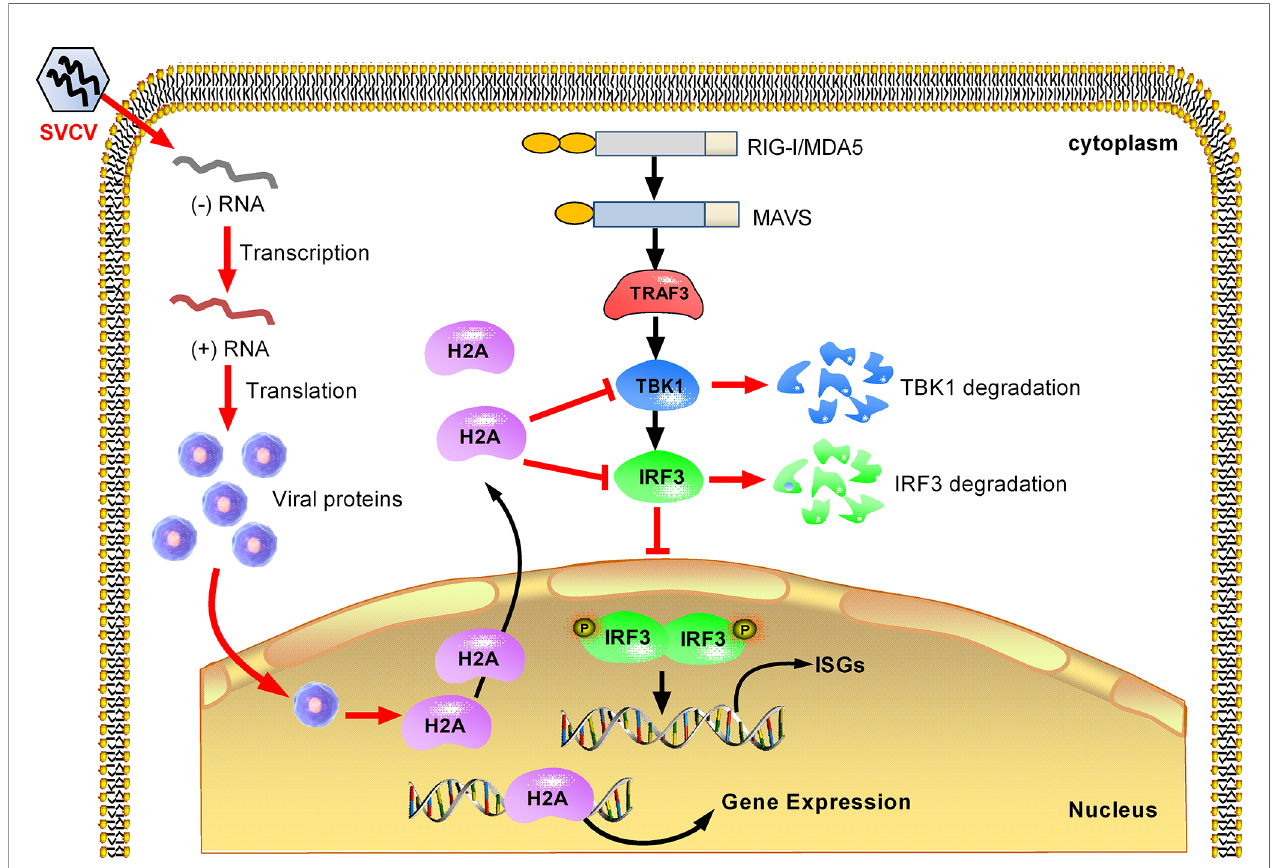
FIGURE 8 | Proposed model illustrating how histone H2A is utilized by SVCV to evade host immune response. Histone H2A is nuclear-localized in the absence of pathogen infection. SVCV infection promotes histone H2A nuclear/cytoplasmic traf fi cking. In the cytoplasm, histone H2A degrades TBK1 and IRF3, which lead to the impaired formation of TBK1-IRF3 functional complex and the decreased expression of nuclear IRF3 protein. In the cell nucleus, the impaired expressions of IRF3 and/or histone H2A inhibit transcriptional regulation of immune genes, and impede the production of type I IFNs and ISGs in response to SVCV